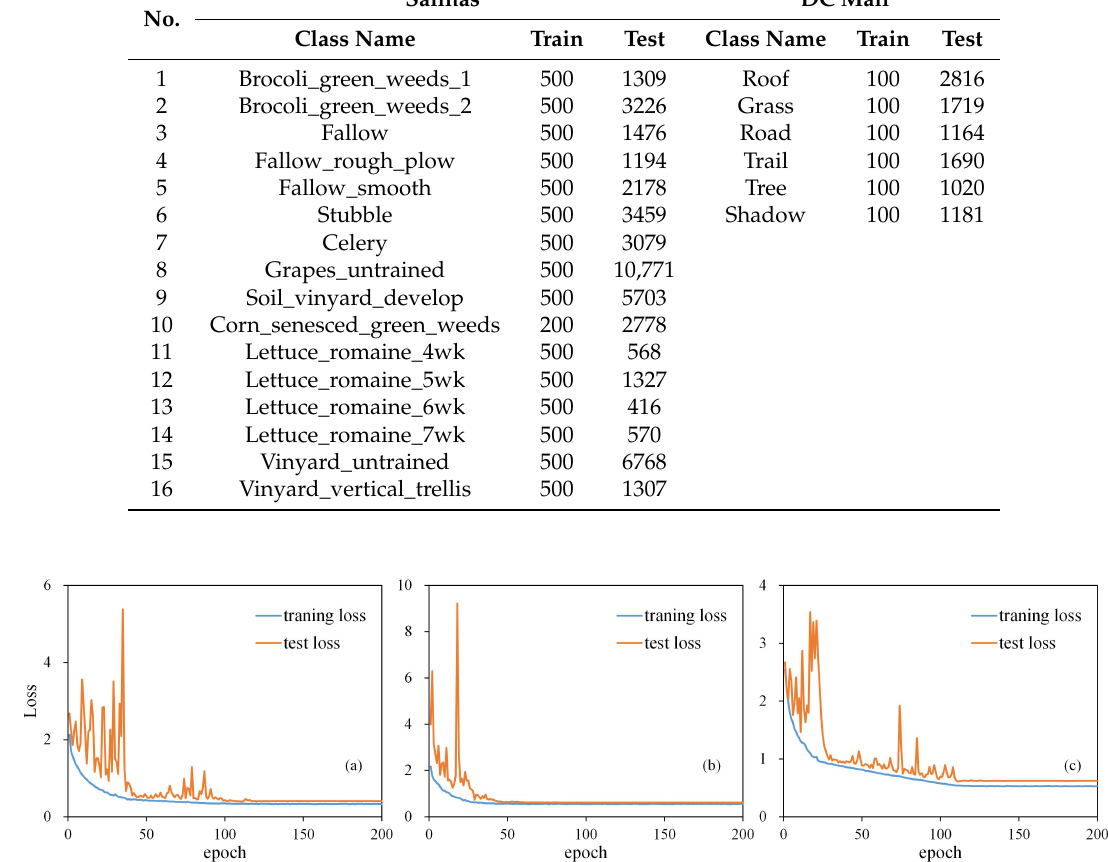
Figure 14. Convergence curves during the fine-tuning process for the DC Mall scene: ( a ) SG-CNN-7, ( b ) SG-CNN-8, and ( c )